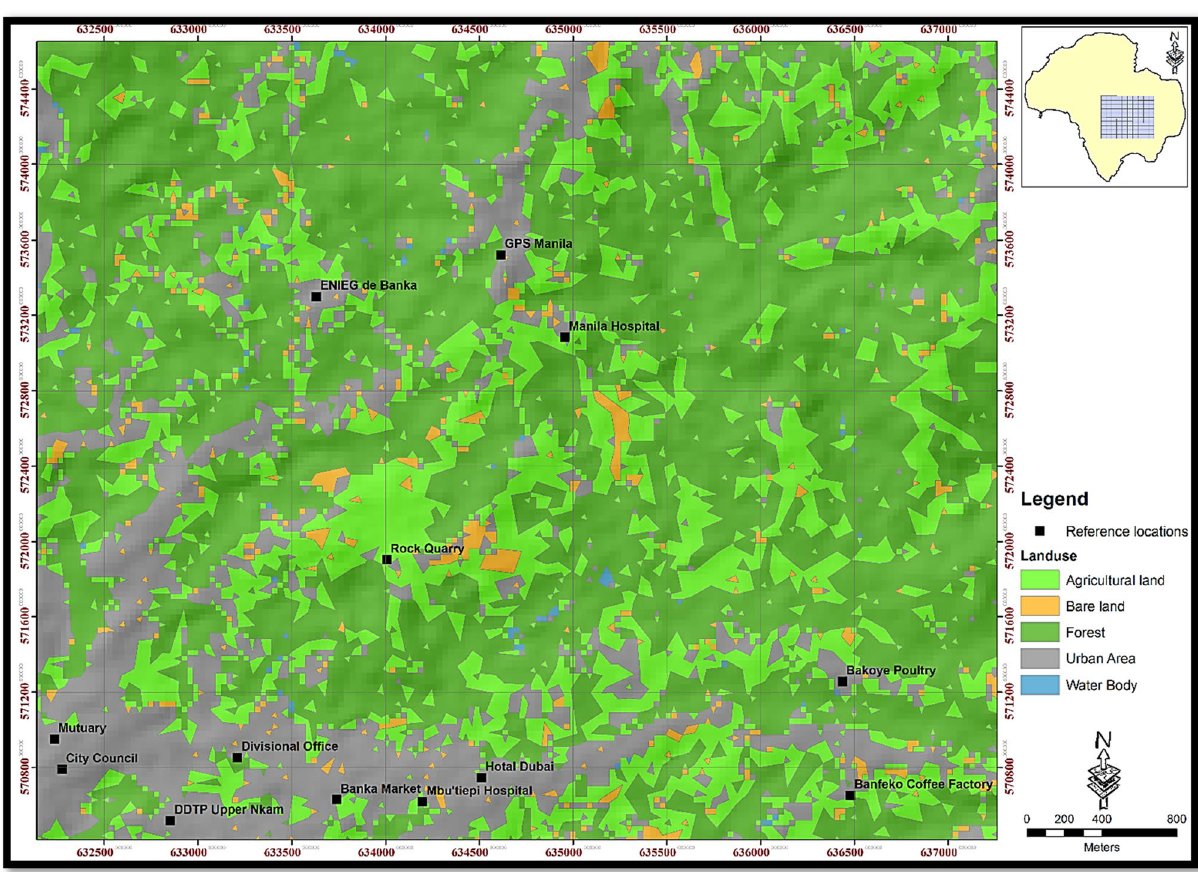
Fig. 8 Land Use and Land Cover map of study area (LULC). It clear from this that the forest and agricultural land covers are the most pre- dominant, followed by built land. Though present the water bodies in the study area are not very large, and there is very little bare